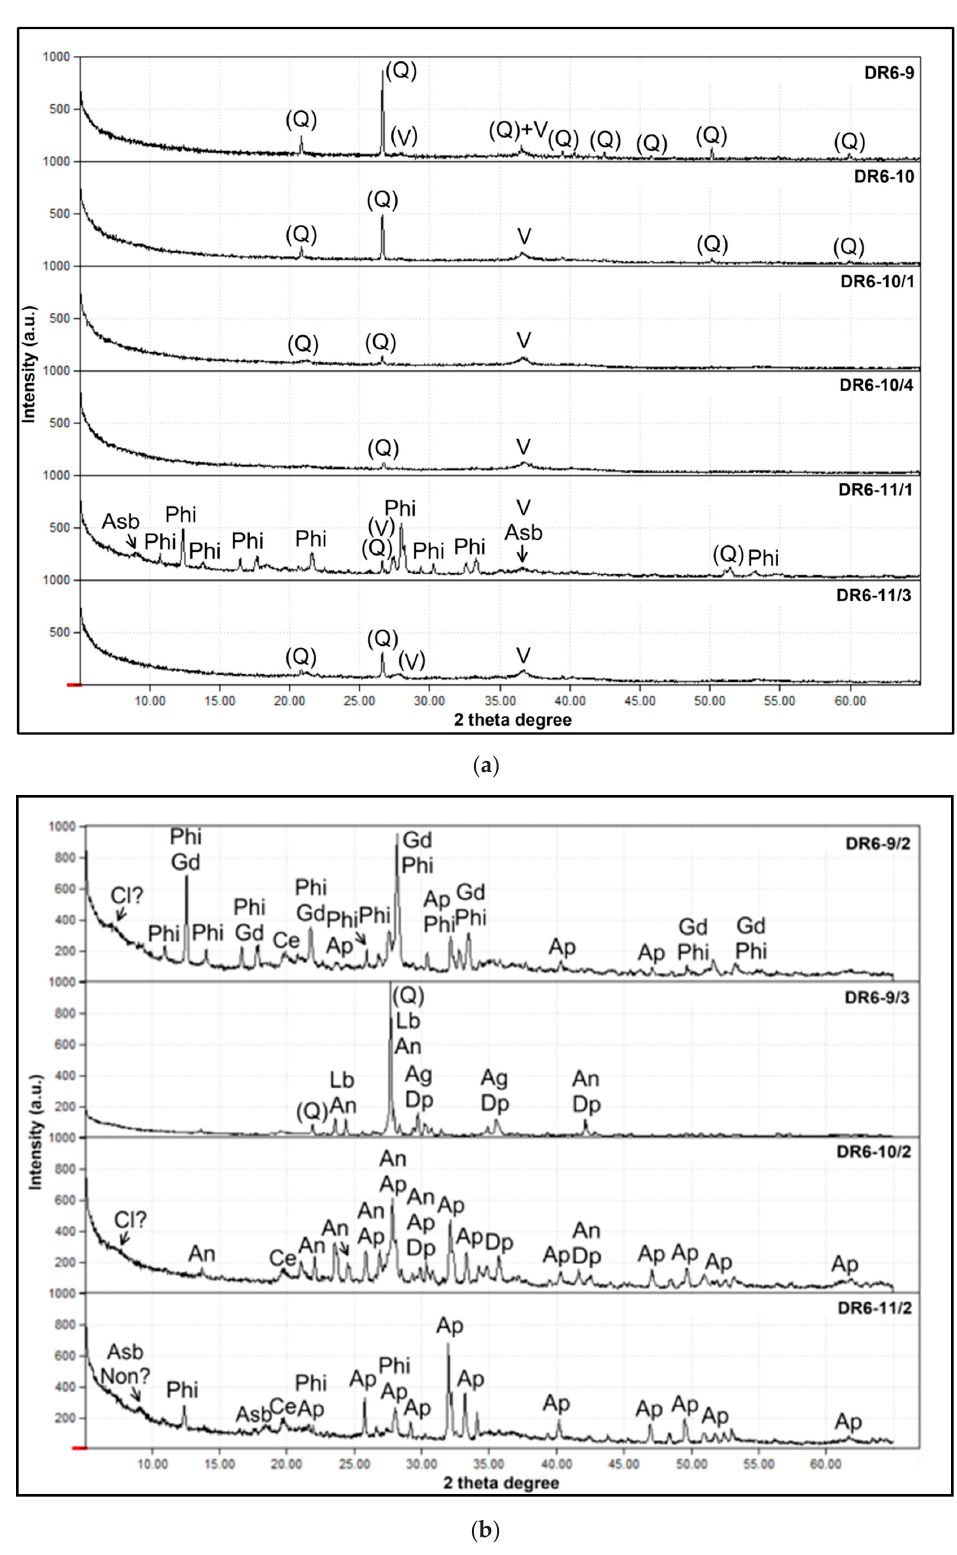
Figure 4. Representative powder diffractograms of the crust samples from the DHR ( a and b ): (Q)-quartz; Fe-Mn oxyhydroxides: V-vernadite, Asb-asbolane; zeolites: Phi-phillipsite, Gd-gismondite; clay minerals: Cl-non-identified clay minerals, Non-nontronite, Ce-celadonite; phospates: Ap-apatite (hydroxyapatite); other silicates: Dp-diopside, Ag-augite; plagioclases: Lb-labradorite, An-andesine.